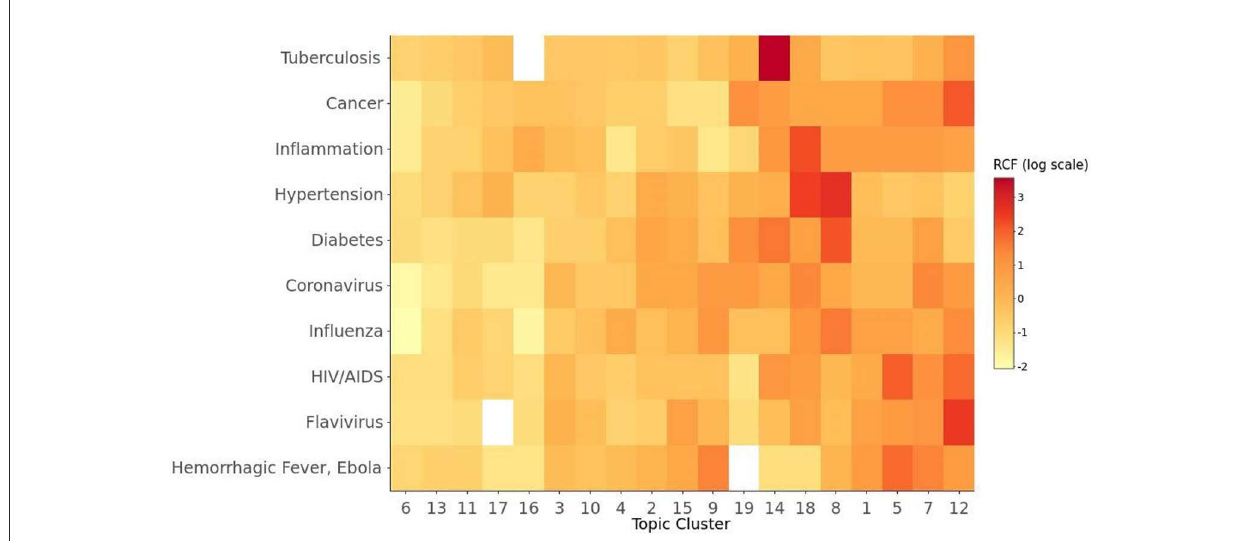
FIGURE3 Mapping of COVID-19 research topics to conditions studied in the cited literature. RCF denotes the Relative Frequency of Citations. The titles for cluster 1 through 19 are as elaborated in Table 1.